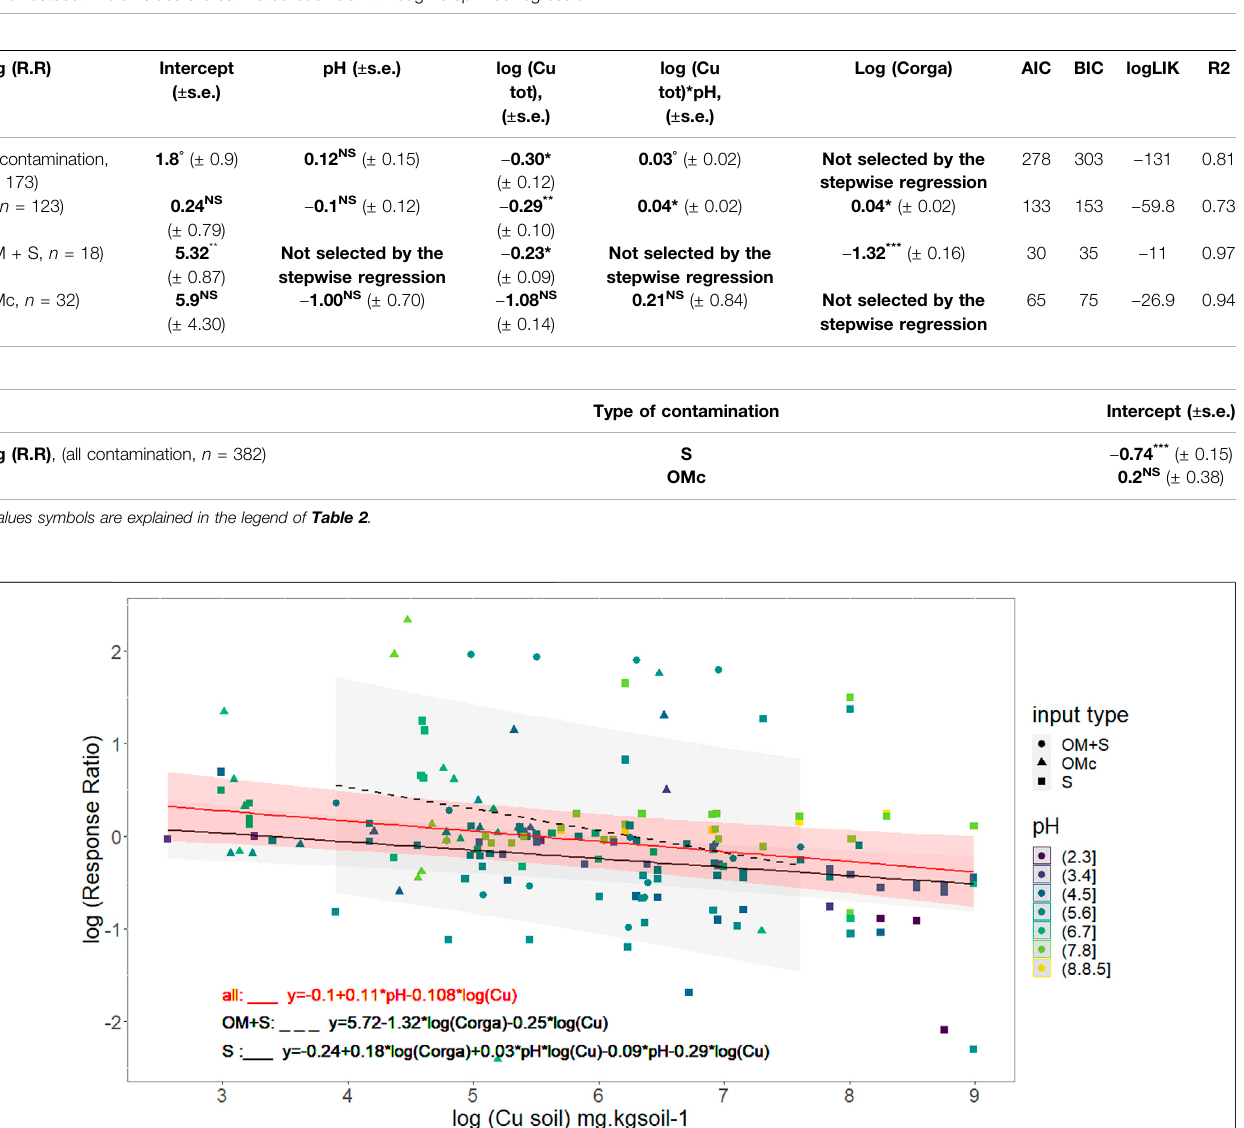
TABLE 3 | (A) Slope and intercept ( ± SE) between log(R.R) and variables selected through stepwise analysis with the linear mixed model for different dataset (all contamination, spikes and contamination due to organic matter additions). (B) Shift of the intercept for log(R.R) between the different groups of qualitative variable (different typeoflaboratory contamination,S (cid:2) Spike, OMc (cid:2) contaminated organicmatter)and thereferenceone(Spike+Organicmattercontamination)only calculatedfor the full dataset. Bold values are estimated coef fi cient through step wise regression.